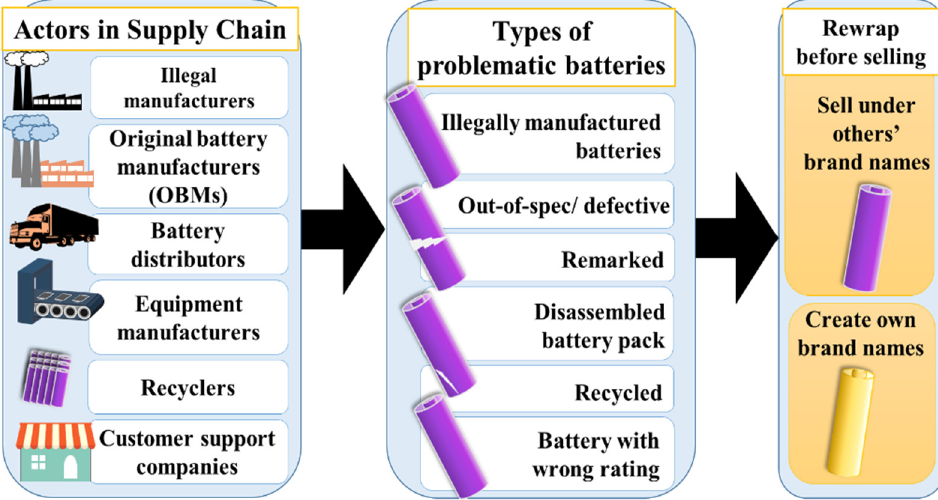
Figure 1. The supply chain of high-risk lithium-ion batteries.